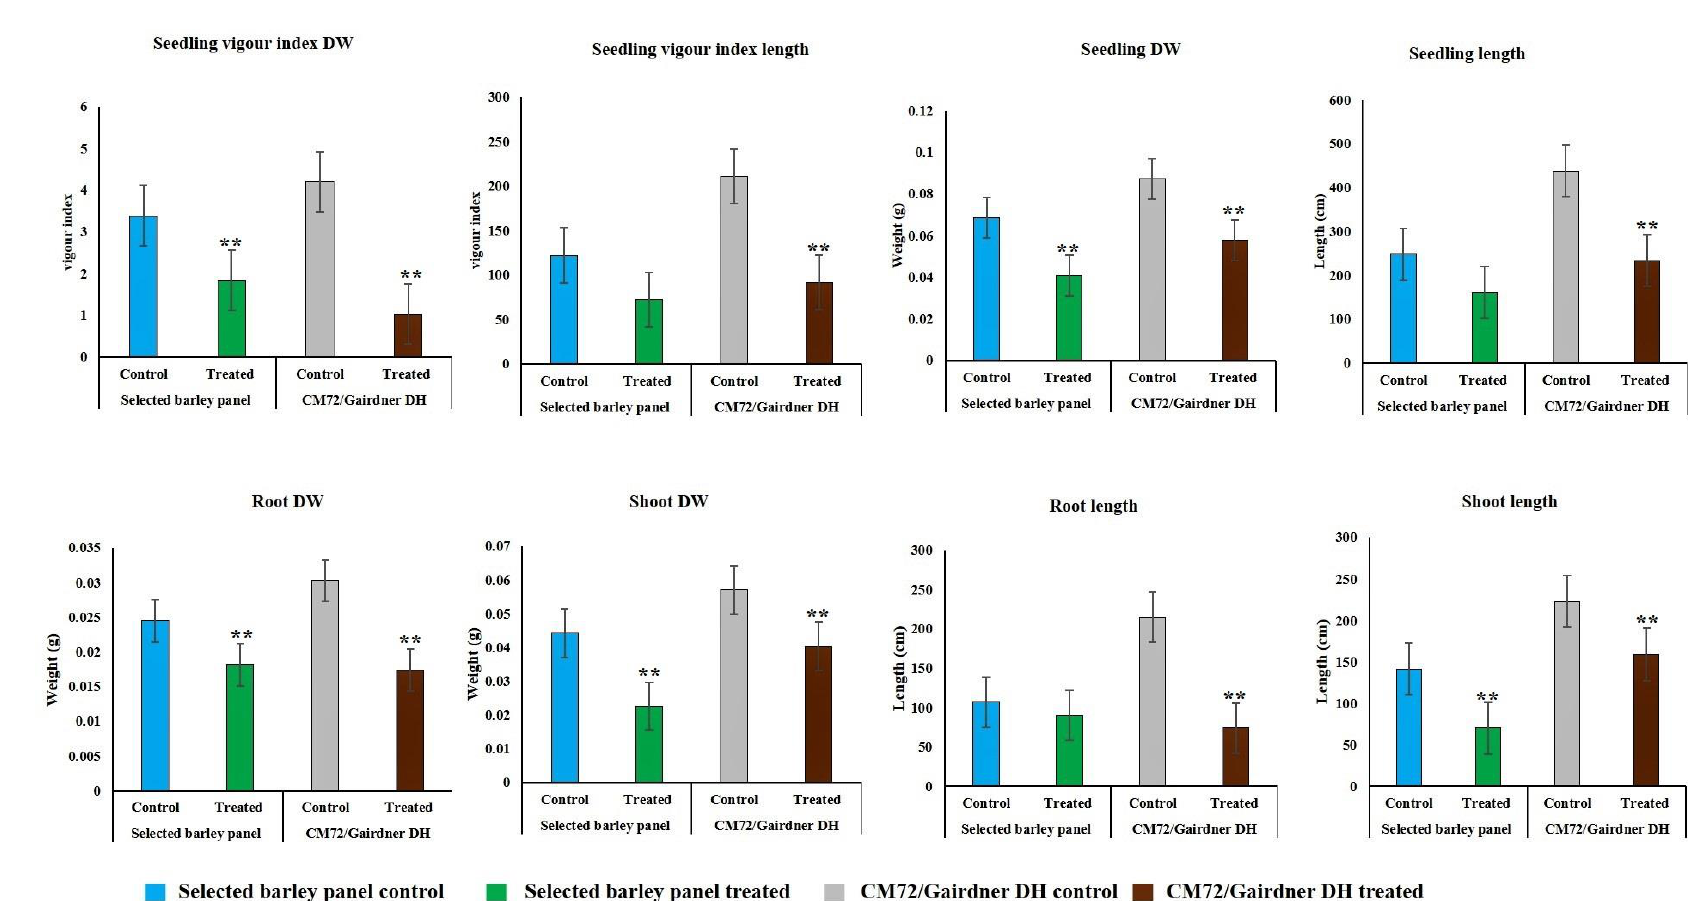
Figure 2. Effect of 150 mM NaCl on seedling survival traits and seedling vigour indices of CM72/Gairdner DH populations and selected barley diversity panel. Values are given as mean ± SD of six experiments in each group. Error bars that are not overlapping differ significantly at p ≤ 0.05 and ** indicate significant difference between control and in the salt treatment at p < 0.05.